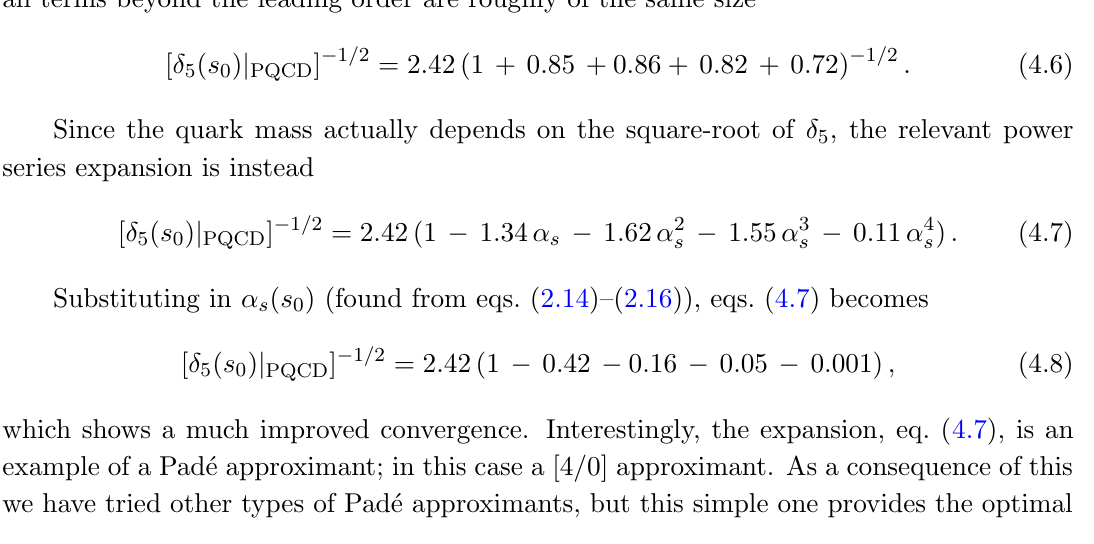
’ (1 : 5 (cid:0) 4 : 0) GeV 2 . 0 0